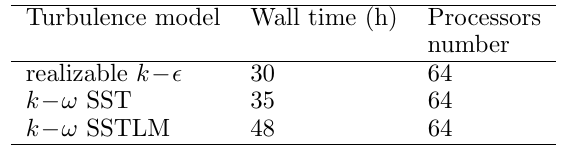
Table 6. Average mass flow rate as a function of the mesh element number.